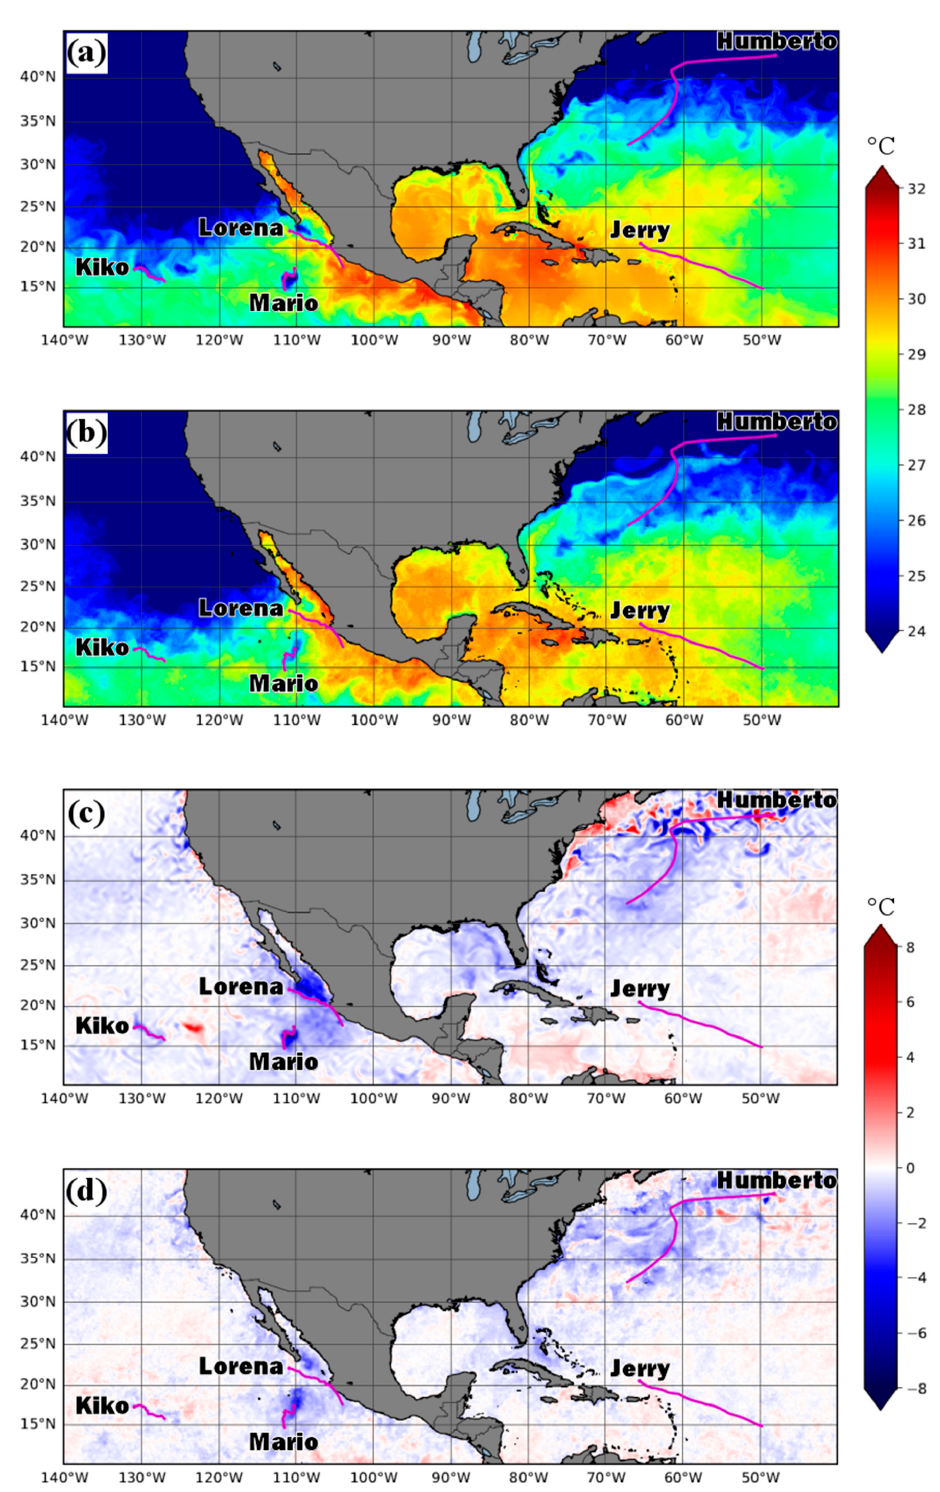
Figure 6. Sea-surface temperature (SST; a , b ) and SST change ( c , d ) for ( a , c ) MPIPOM-TC model output at a lead time of 72 h for a forecast initialized at 1800 UTC 09 September 2019 and ( b , d ) satellite observations coincident with that forecast hour (1800 UTC 12 September 2019). HWRF-B track forecasts are shown in magenta for five active TCs that had storm-following nests. The region of interaction between Mario and Lorena is shown at a larger scale in Figure 7. SST units are in ◦